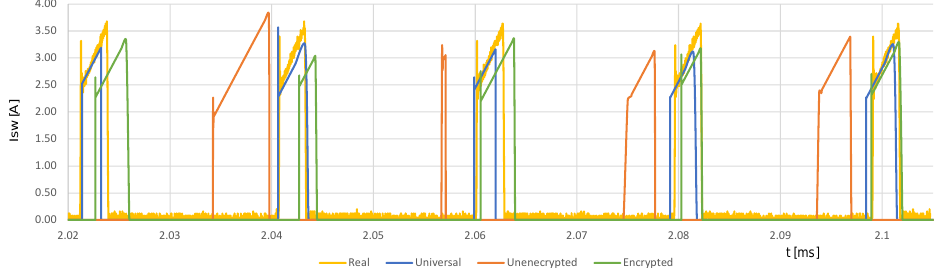
Figure 16. I sw models and real measurement time graph curves.